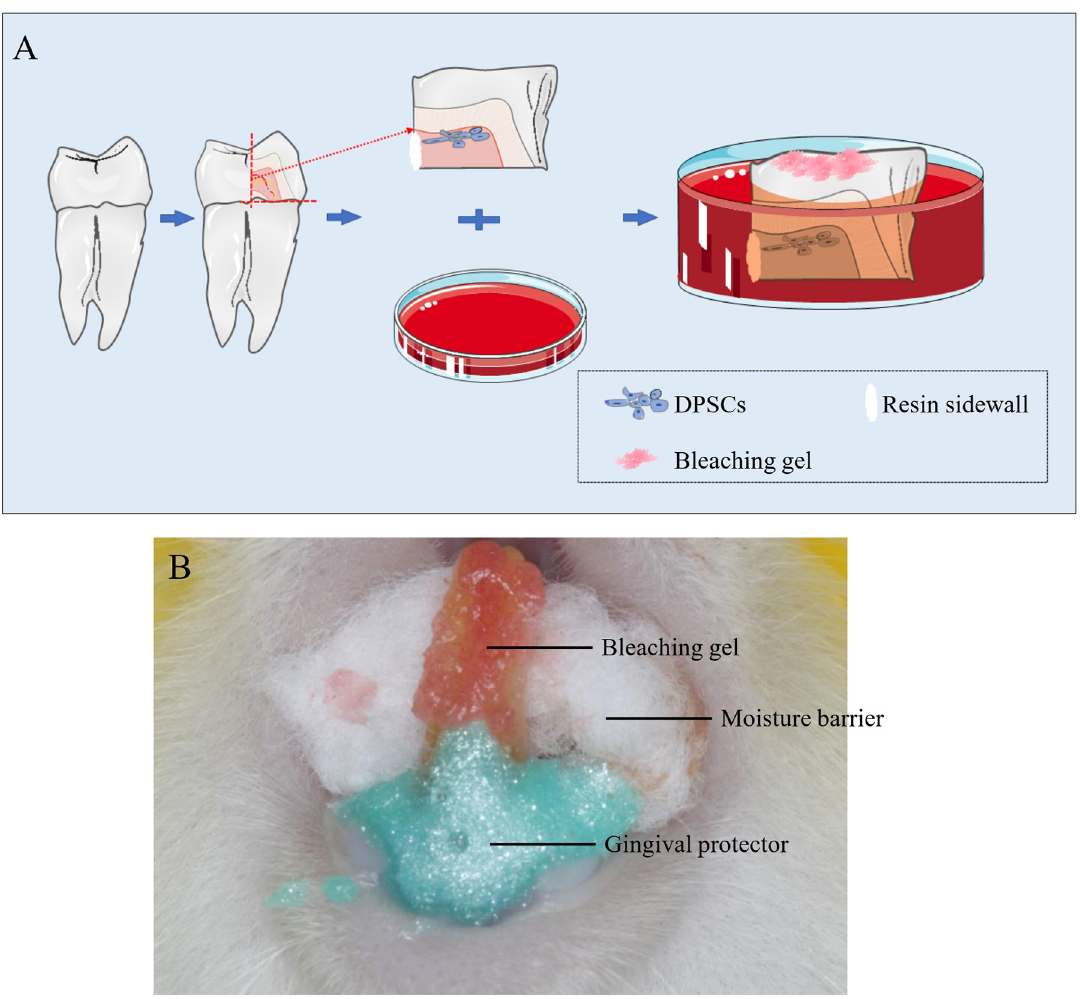
Fig 1. Schematic diagram (A) of the enamel-dentin disc and rat incisor model